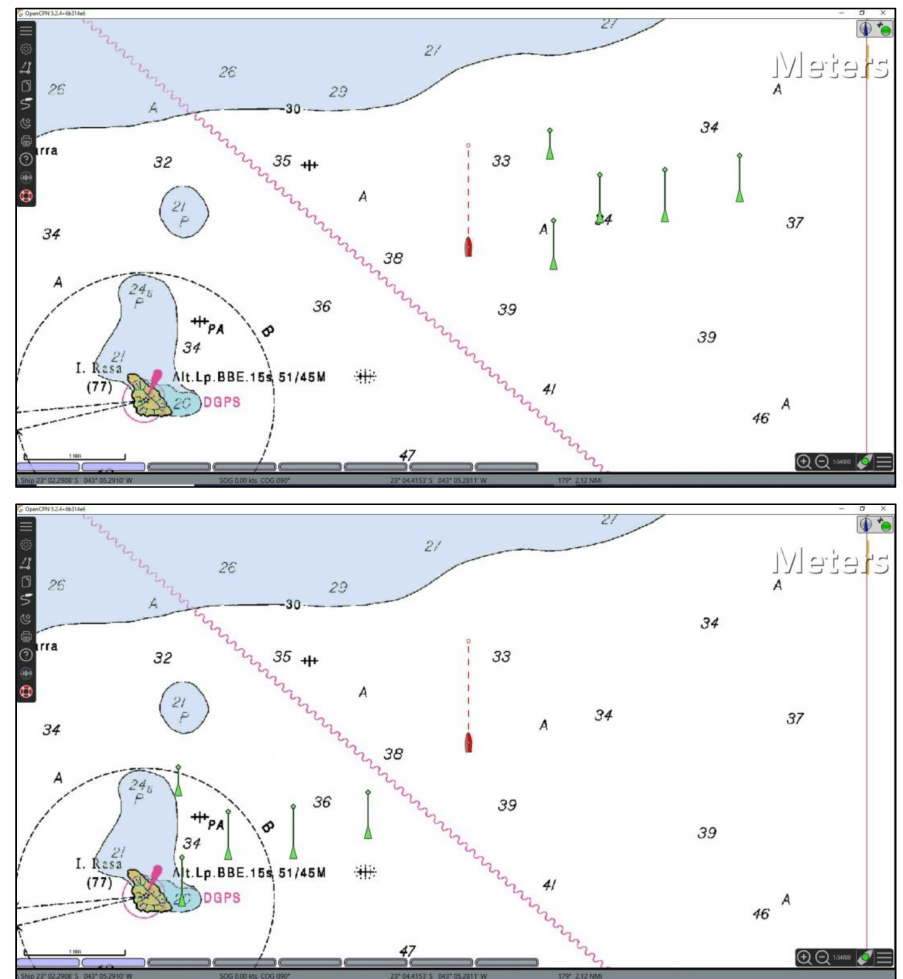
Figure 17. Examples of scenarios where the attack command is the set of five false AIS plots shown in Figure 16 (randomly